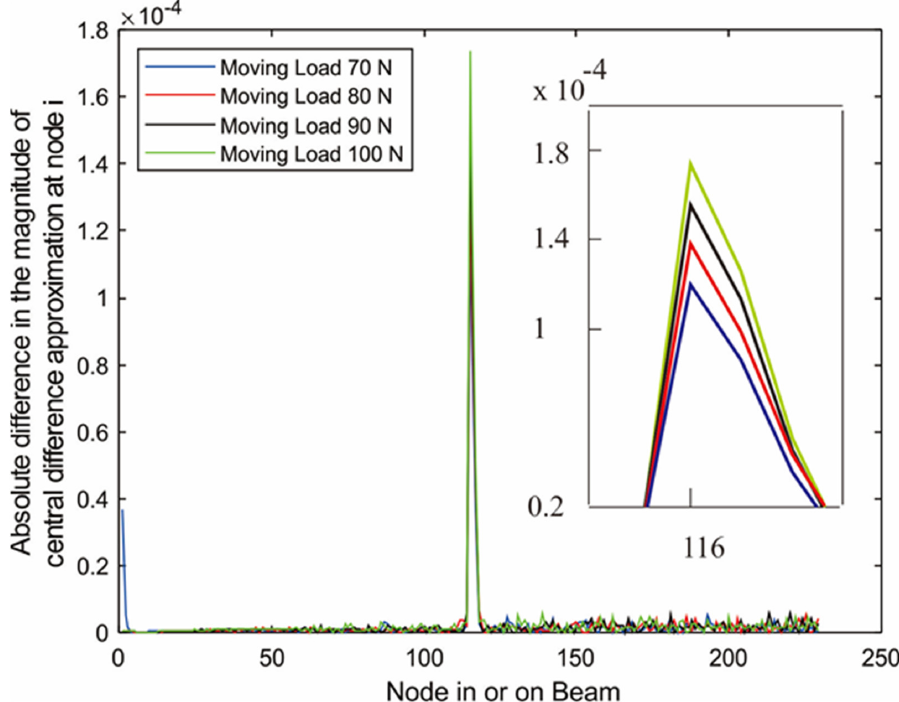
Figure 15. Absolute difference between the central difference approximation of displacement of the uncracked and the cracked (Node 116) cantilever beam subjected moving load.